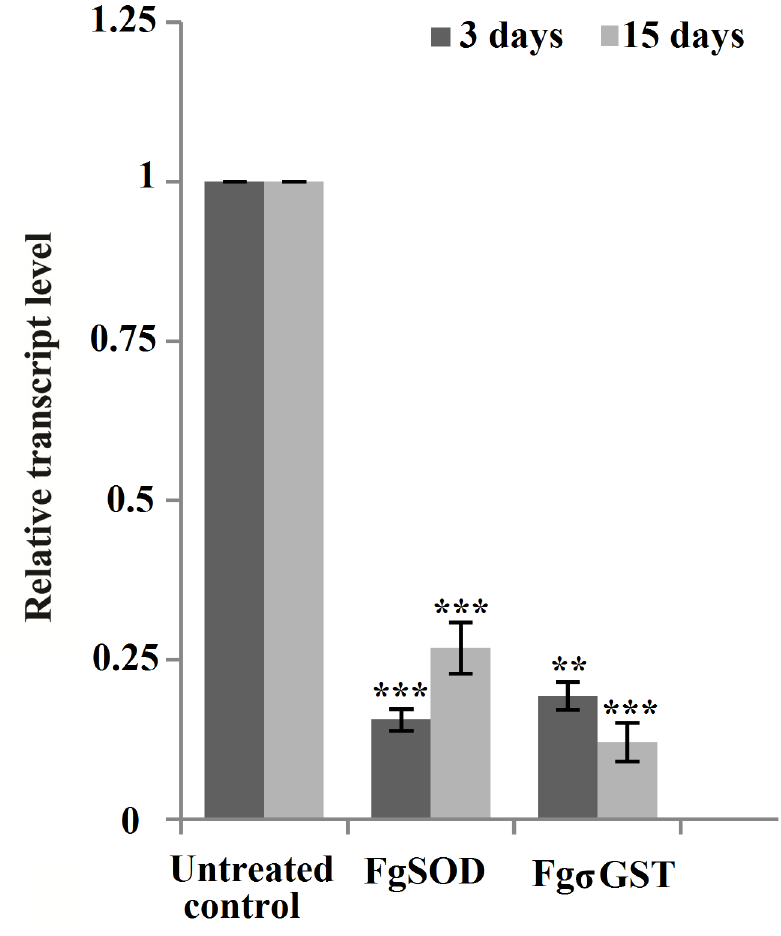
Fig 5. Persistence of mRNA transcript suppression at 15 days post-dsRNA treatment. The F . gigantica NEJs treated with 50 ng / μ l dsRNA specific to SOD and σ GST genesanalyzedat 3 and 15 days post-RNAi, respectivelyshowingsignificantknockdown of the mRNA transcripts post-3 rd and 15 th day of exposure.